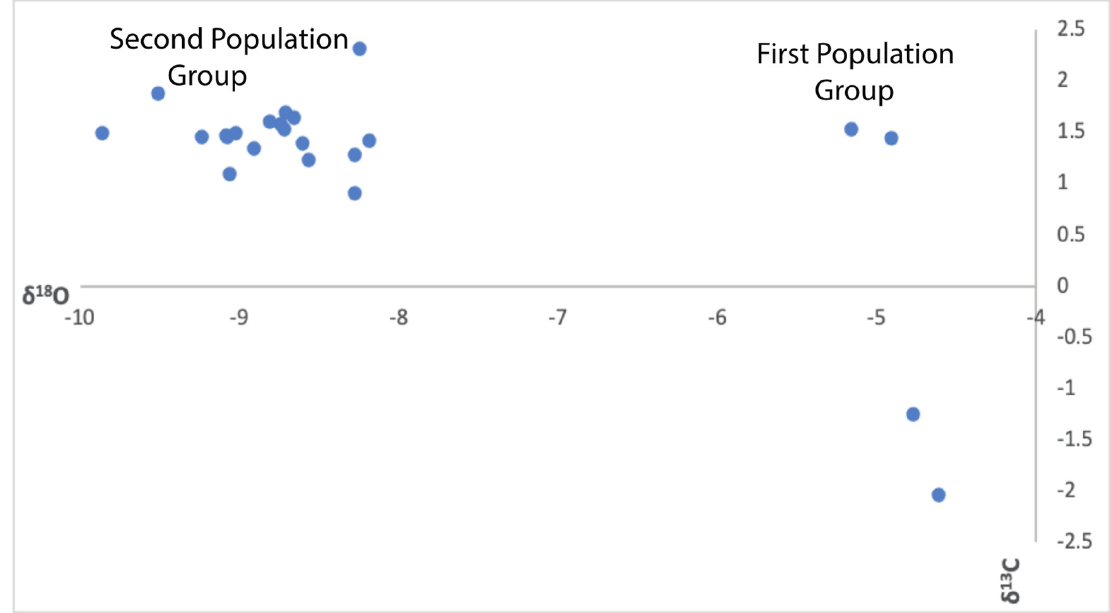
Figure 10. Oxygen and carbon isotopic compositions of carbonate rocks of the Bekhme Formation, close up two population groups of O-C isotope values.